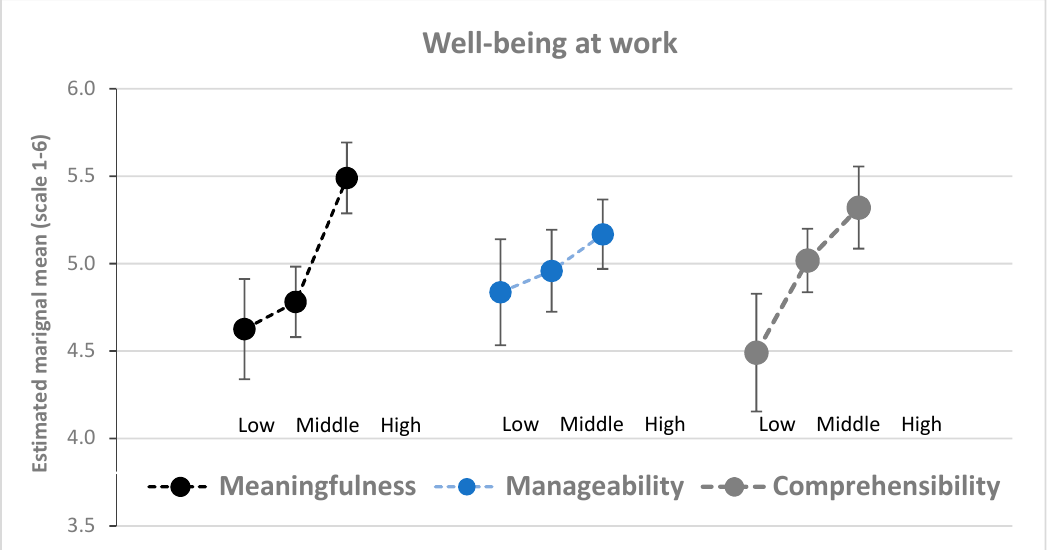
Figure 4. Estimated means of well-being in the workplace in groups (tertiles) with low, medium, and high meaningfulness, manageability, and comprehensibility ( n = 246). Error bars indicate 95% confidence intervals.